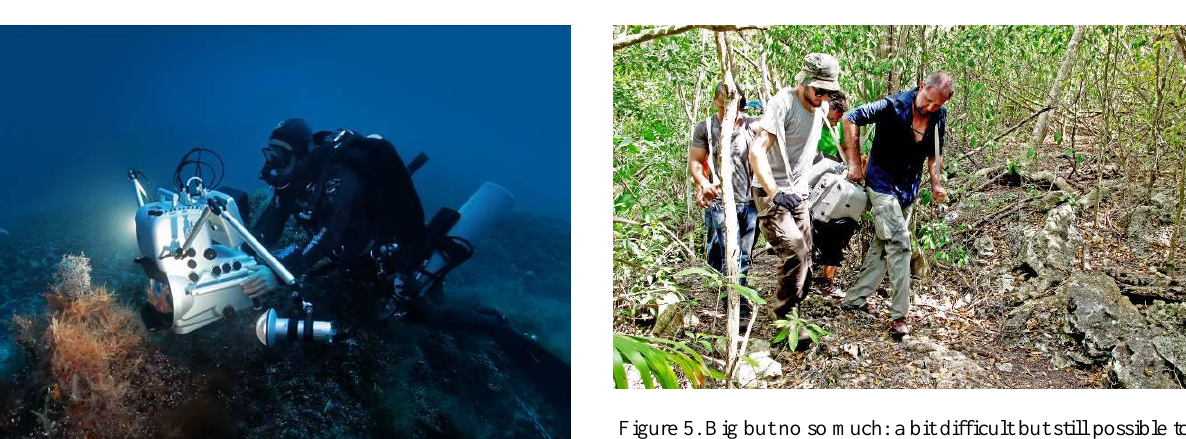
Figure 5. Big but no so much: a bit difficult but still possible to go to film a cenote in the meddle of Cuban forest, very far from the